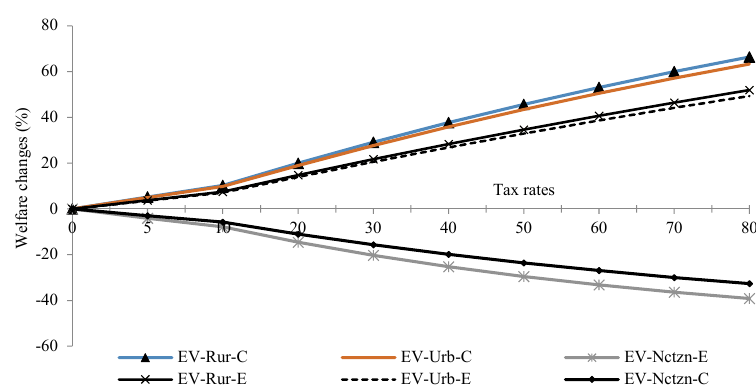
Fig. 6: Welfare changes of different rates of climate change taxes (from 0 to 80 $ per ton of CO 2 ) Note: Rur, -Urb and -Nctzn denote rural, urban and noncitizen households, respectively. -E and -C denote energy and carbon taxes, respectively